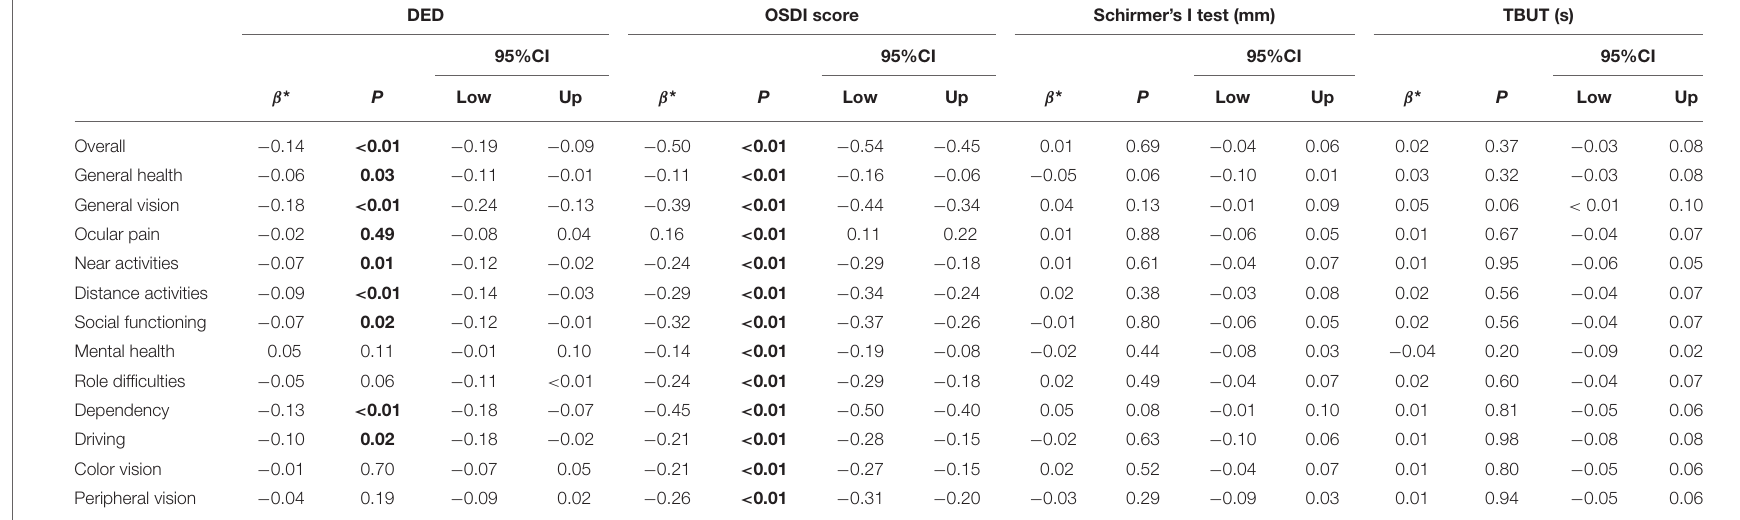
TABLE 4 | Multiple linear regression on dry eye disease and vision-related quality of life based on NEI-VFQ-25 in all the